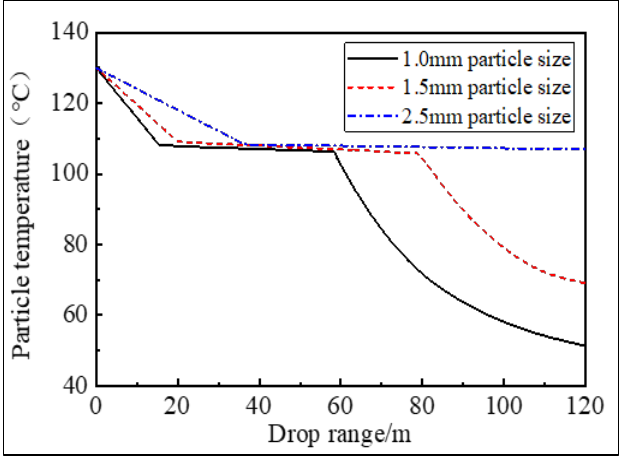
Figure 11. The diagram of particle cooling in tower.